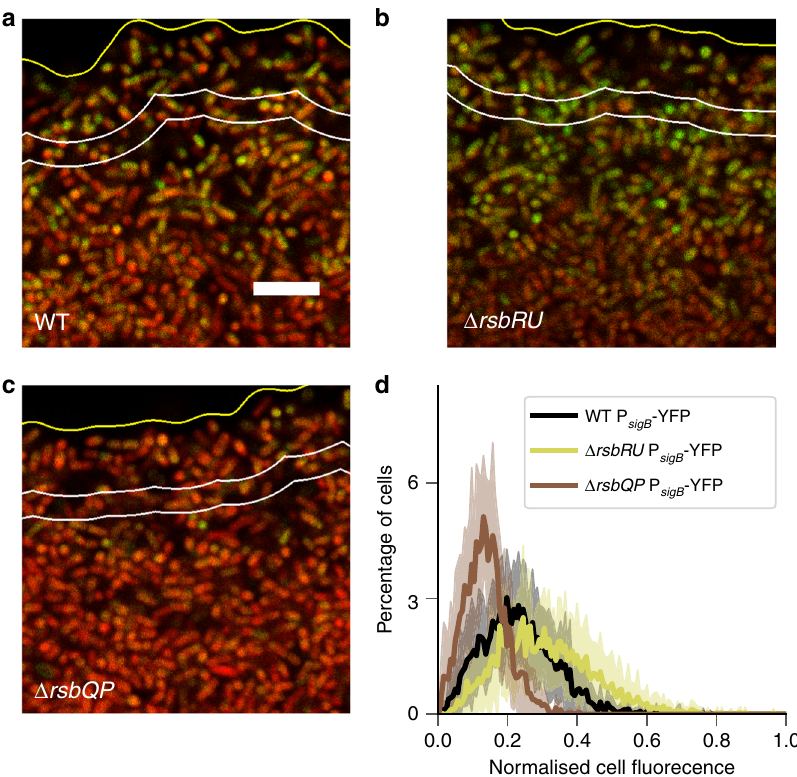
Fig. 3 Heterogeneous activation of P sigB -YFP in individual cells in bio fi lm colonies is mediated through the energy stress pathway. a – c High magni fi cation confocal images of the top 25 μ m of the central part of a B. subtilis bio fi lm. Merged P sigA -RFP (red) and P sigB -YFP (green) channels for a WT, b Δ rsbRU , and c Δ rsbQP, respectively. Yellow lines indicate the top edge of the bio fi lm and the white lines mark the 5 and 7 μ m isolines. Scale bar is 5 μ m. d Histograms of normalised cell fl uorescence in a range from 5 to 7 μ m from the top of the bio fi lm. The YFP values are normalised by the mean RFP fl uorescence in the range for that image. The error represents the standard deviation of the histogram for each image (WT histograms from 4231 cells, n = 24 images from fi ve experiments, Δ rsbRU histograms from 3268 cells, n = 18 from three experiments, Δ rsbQP histograms from 2481 cells, n = 16 from three experiments). Source data are provided as a Source Data fi